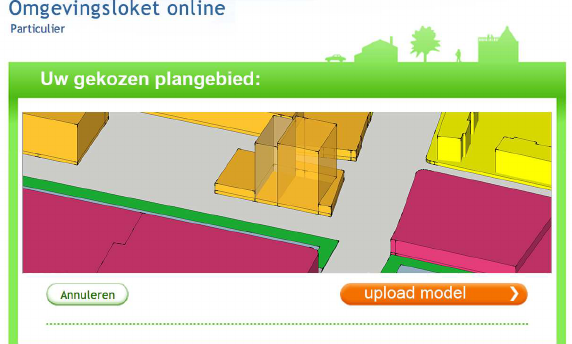
Figure 10. Mock-up of the building permit portal for 3D